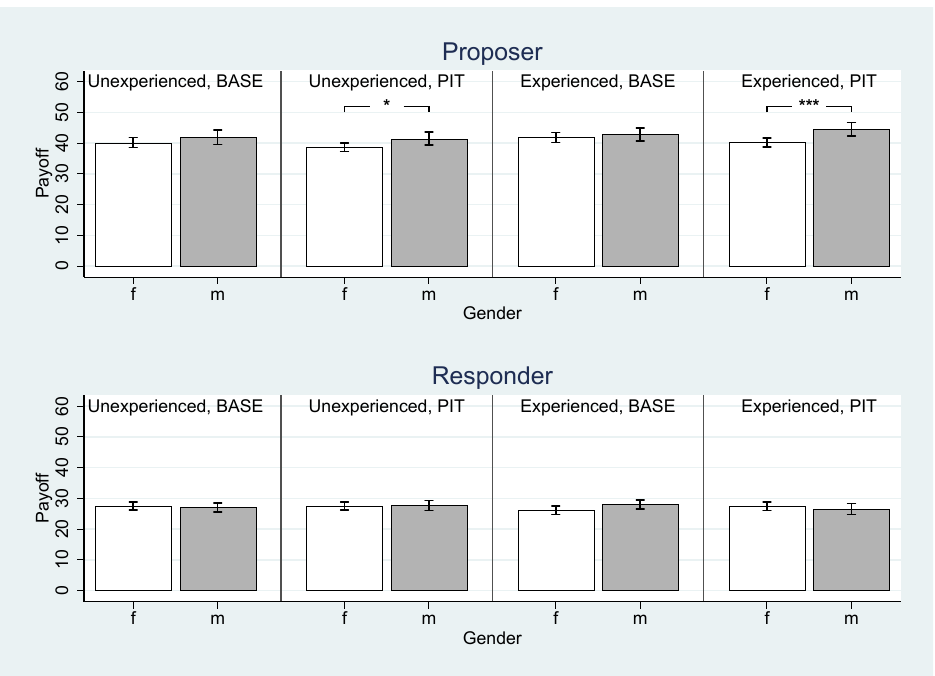
Figure 1. Players’ Payoffs by Role, Experience, Treatment, and Gender. Average payoffs in tokens. The number of observations for each bar, means, and standard errors, as well as t -tests (Welch tests) can be taken from Table A2 in Appendix A. Significance levels: * p ≤ 0.10, ** p ≤ 0.05, and *** p ≤ 0.01. Error bars represent 90% confidence intervals.